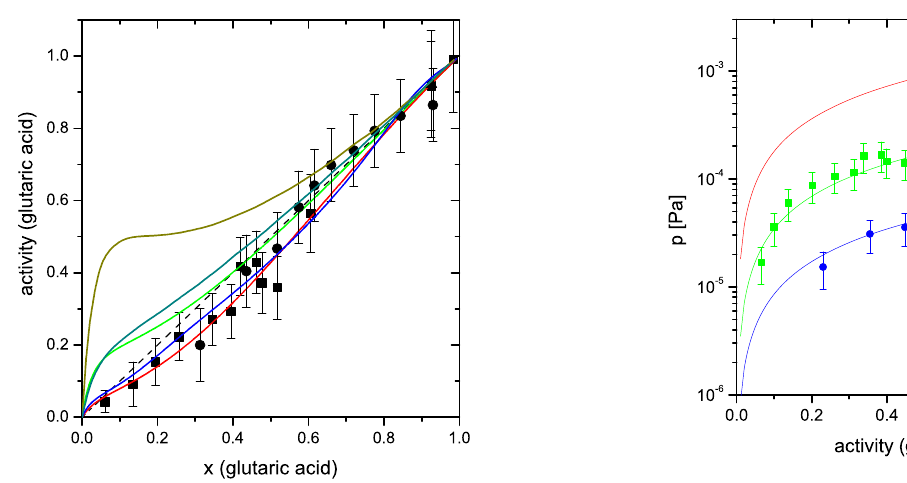
Fig. 3. Vapor pressure from evaporation rates of glutaric acid plot- ted versus activity from UNIFAC-Peng (Peng et al., 2001). Data at T = 281 . 3K: , T = 290 . 9K: (cid:4) , T = 303 . 2K: N . Lines are the results of one fit to all data using Eq.